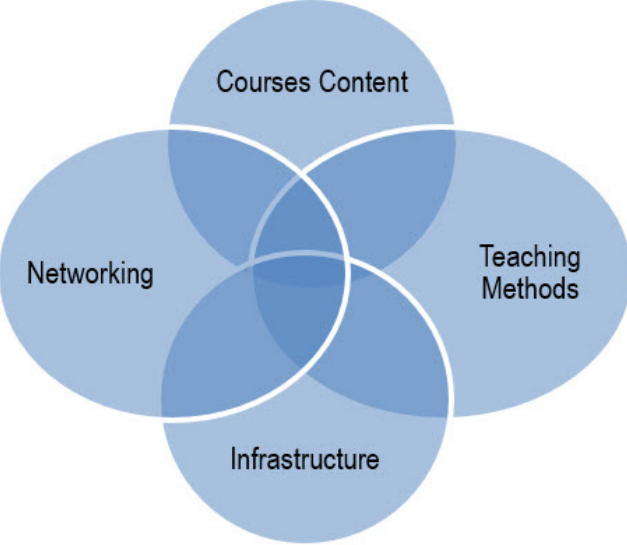
Figure 2. Main group of tools for cognitive engineering